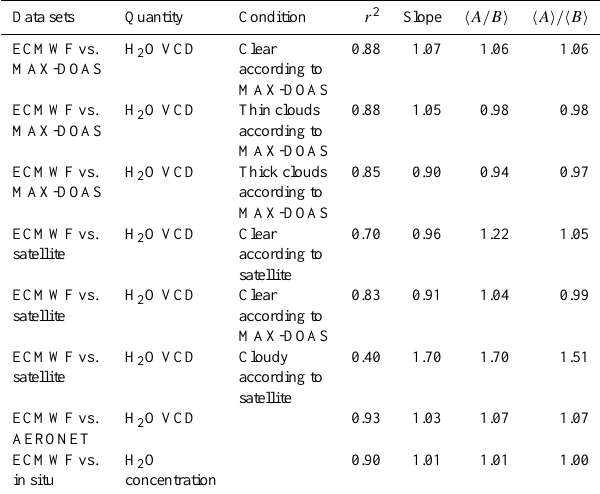
Table 3. Results of selected correlation analyses between ECMWF data and the other data sets. Also the average ratios of individual data pairs h A/B i and h A i / h B i are